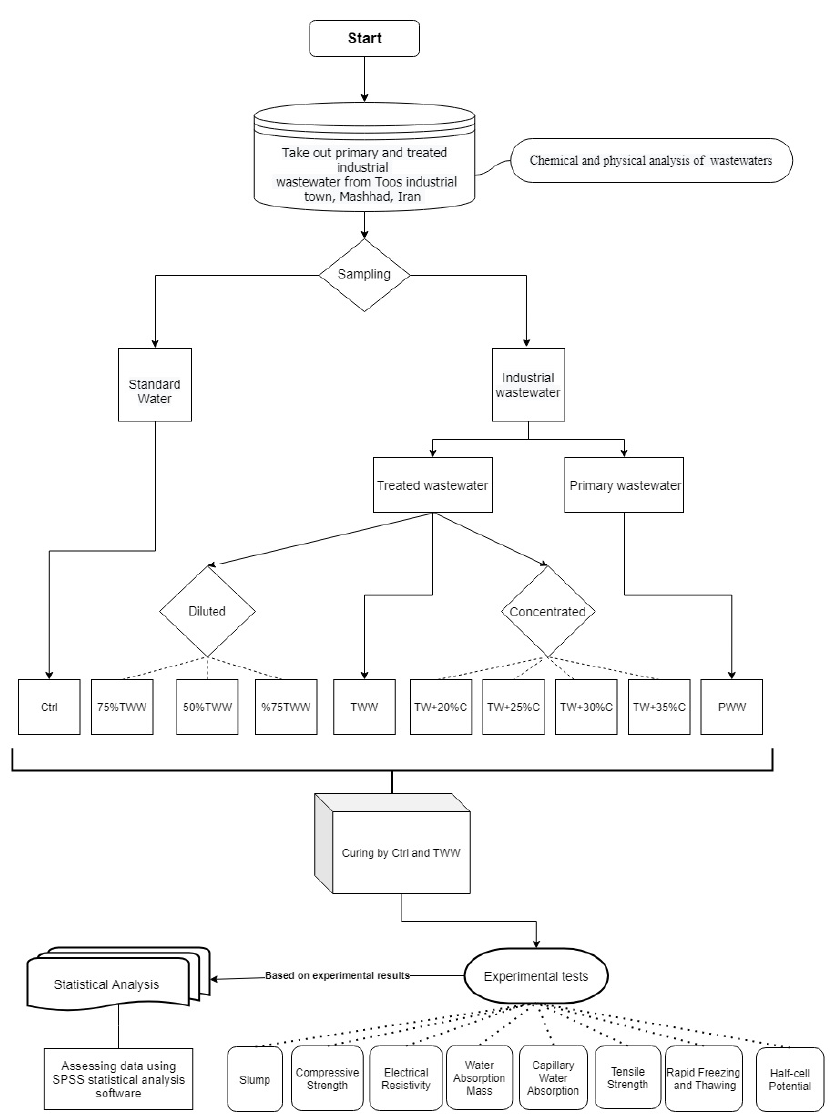
Figure 1. Flowchart of methodology.